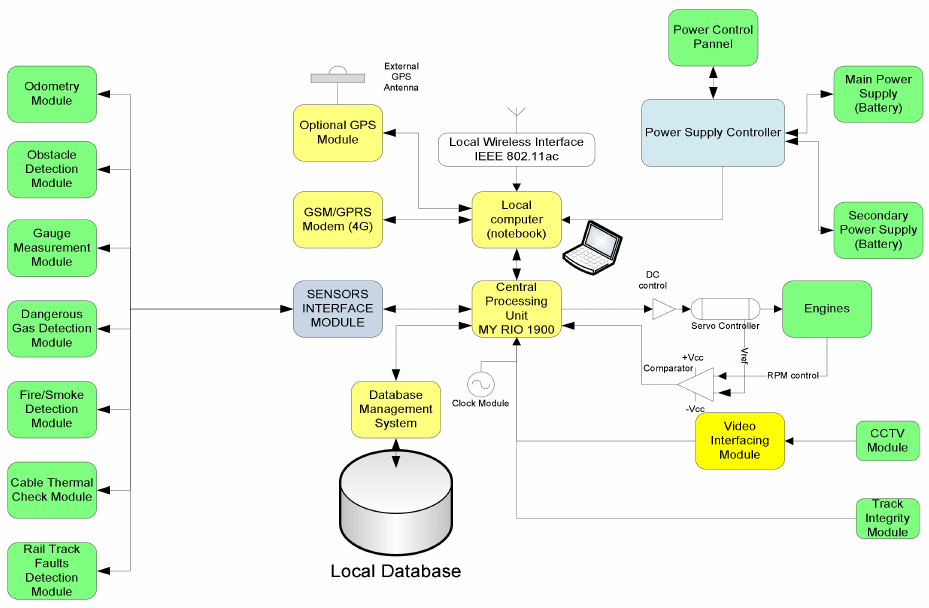
Figure 1. General functional blocks diagram of the autonomous